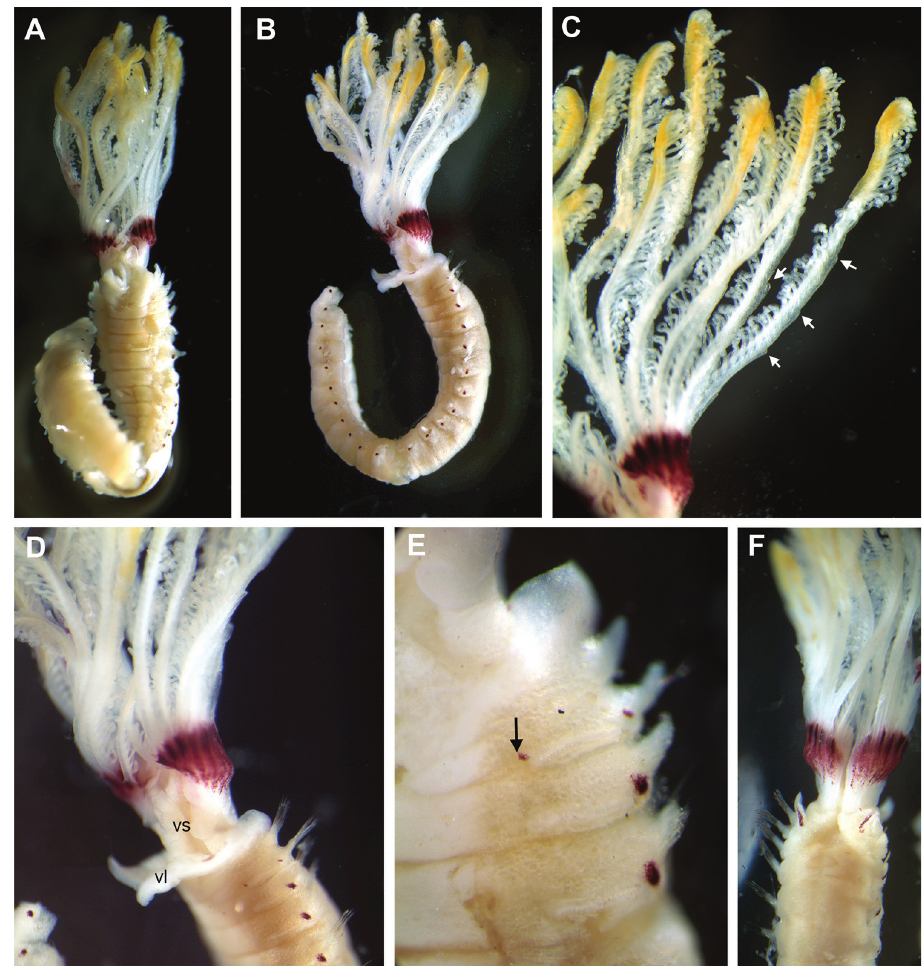
Figure 7. Pseudobranchiomma pallida sp. n. AM W.36366: Photographs. A Whole specimen, ventral view B Whole specimen, lateral view C Lateral radioles D Detail of base of radiolar crown and anterior segments E Anterior thoracic segments, ventrolateral view F Anterior end, dorsal view. vl, ventral lappet; vs, ventral sac; white arrows, serrations of radiolar lateral flanges; black arrow, gap between ventral shields and thoracic